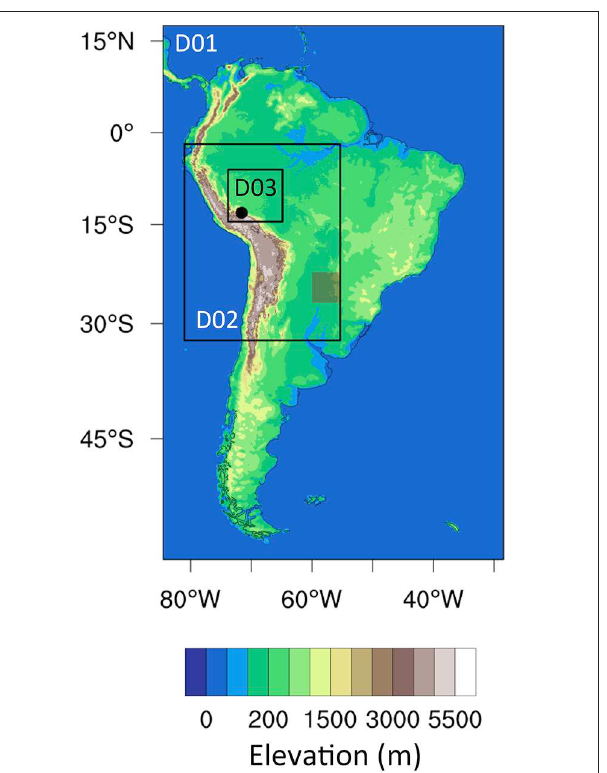
FIGURE 3 | Domain setup for numerical simulations with 3 nested domains with increasingly higher grid resolution: D01 ( 18 km ), D02 ( 6 km ), and D03 ( 1.2 km ). The small shaded box shows the region where the ECMWF reanalysis data are used for detecting the events. The black circle marks the region highlighted in Figure 1 where the rain-gauges are